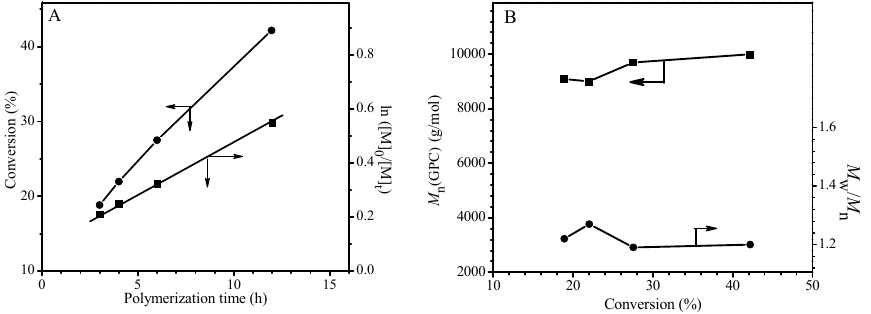
Figure 1. Polymerization kinetics ( A ) and relationship of M n (GPC) and M w / M n with conversion ( B ) for the polymerization of Methyl methacrylate (MMA) with the feed molar ratio of MMA/TPPT/AIBME = 100/2/1 in anisole (50 wt %) at 70 °C.